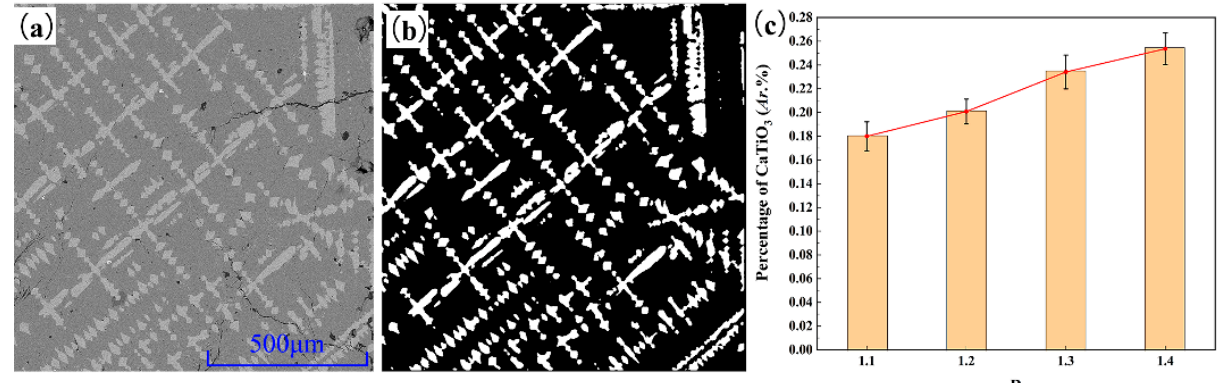
Figure 5. ( a ) The optical micrographs of cross sections of the samples with basicity of 1.1; ( b ) the recognition of CaTiO 3 corresponding to ( a ); ( c ) the function of CaTiO 3 area percentage with basicity.